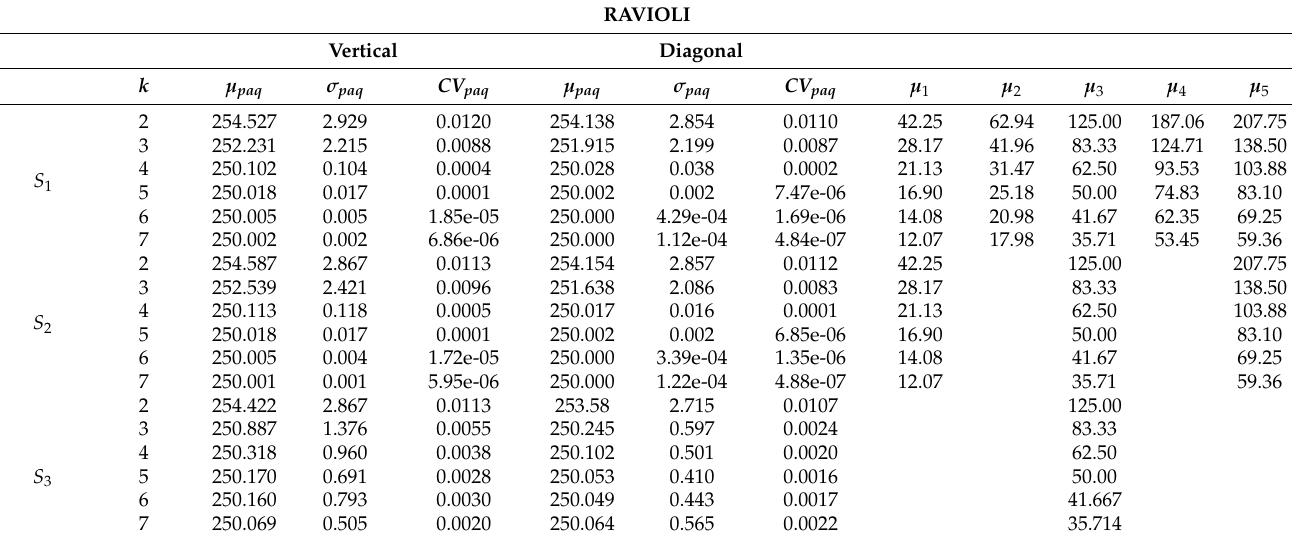
Table 6. Results of the S 1 , S 2 , and S 3 strategies, for k = 3, 4, 5, 6, and 7, and γ =